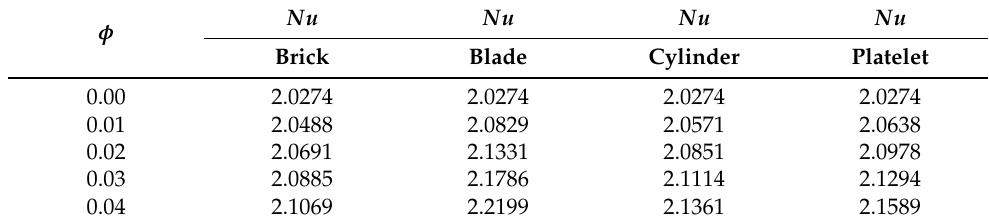
Table 5. Numerical analysis of Nusselt number enhancement for different shapes of nanoparticles.